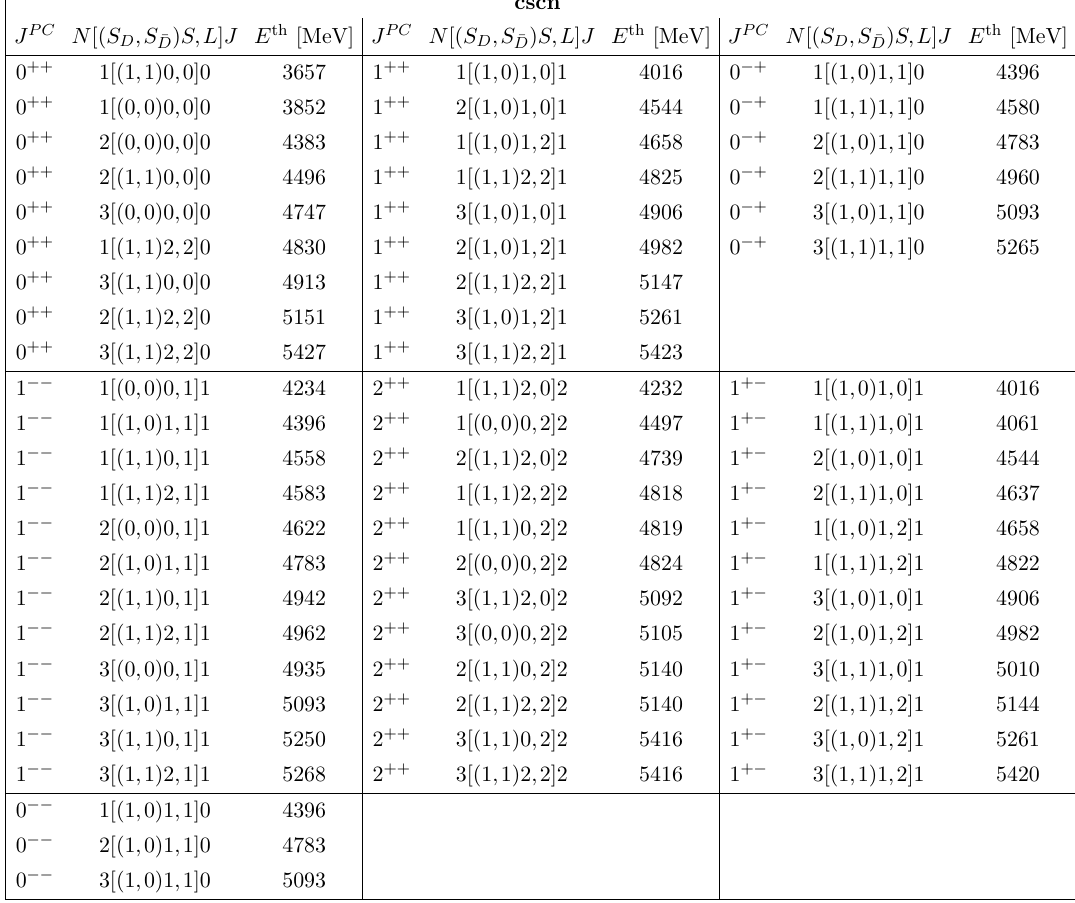
Table 7 . Masses of cs (cid:22) c (cid:22) n ( cn (cid:22) c (cid:22) s ) tetraquarks, obtained by solving the eigenvalue problem of eq. (4.1). We report states up to the second radial excitation. They are labelled thus: N is the radial quantum number; S D , S (cid:22)D are the spin of the diquark and antidiquark, respectively, coupled to the total spin of the meson, S ; the latter is coupled to the orbital angular momentum, L , to get the total angular momentum of the tetraquark, J . In the case of scalar-axial-vector diquark con(cid:12)gurations, there are two possible ways of combining diquarks to get a tetraquark with strangeness S = (cid:6) 1. They are are axial-vector. In these cases, the values of the tetraquark masses shown are the average of